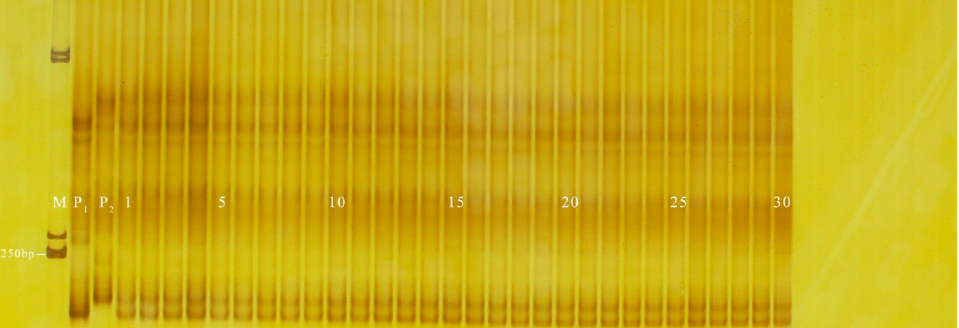
Figure 10. Purity identification of some plants of ‘Fenxianzi 11 ′ wax gourd by GX2. M: DL2000 DNA Marker; P 1 : ymy-24-1-6-1 (nearly spherical); P 2 : GF-7-1-1 (cylindrical); 1–30: ‘Fenxianzi 11 ′ wax gourd.